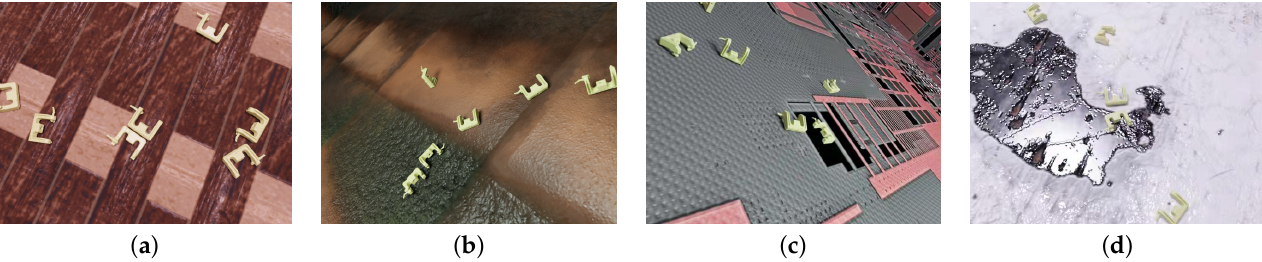
Figure 4. Examples of the rendered images. ( a – d ) are examples that random selected from the synthetic dataset with different view